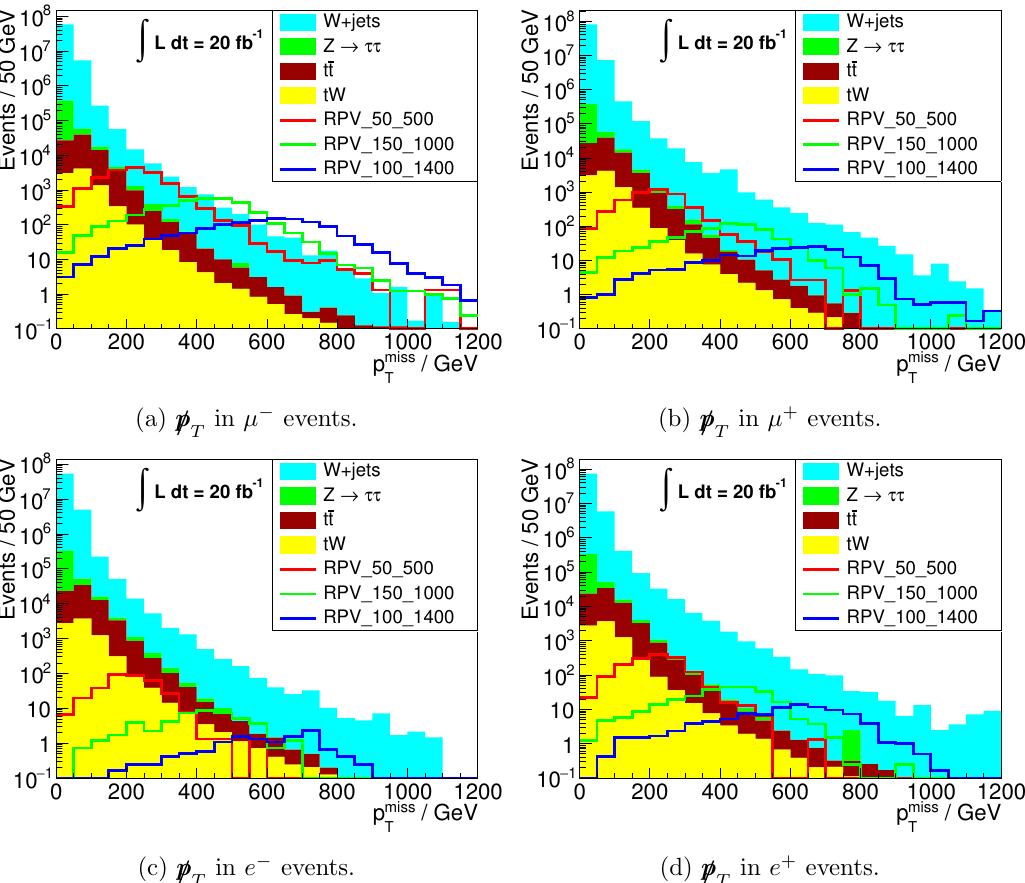
Figure 7. The distribution of =p